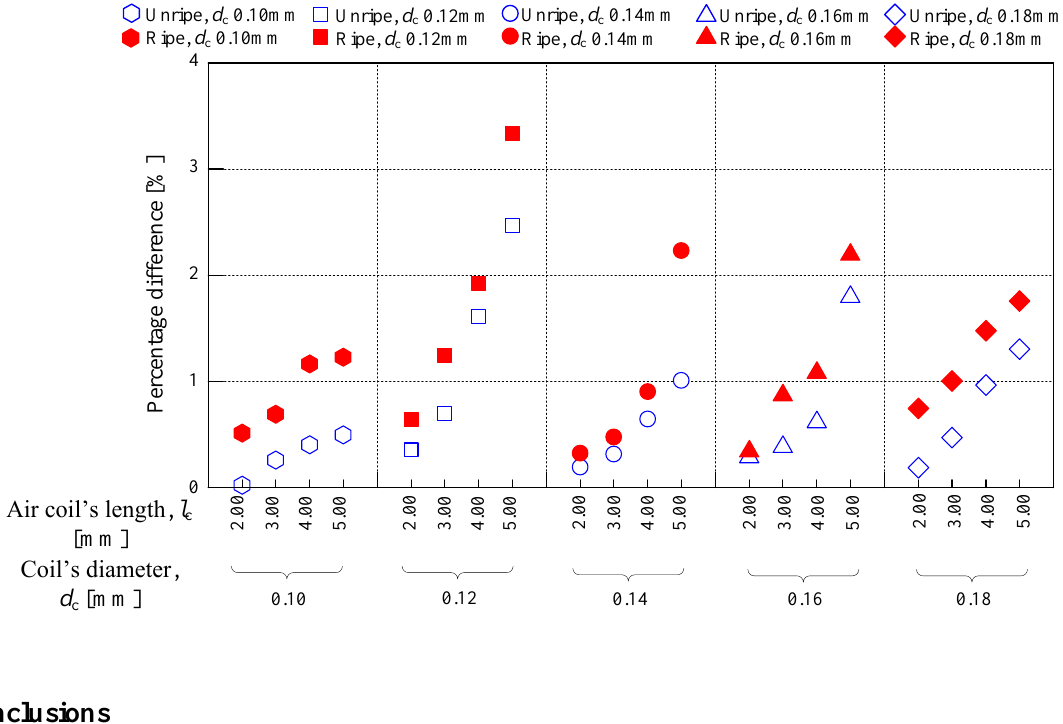
Figure 10. Percentage difference of various coil diameter and air coil